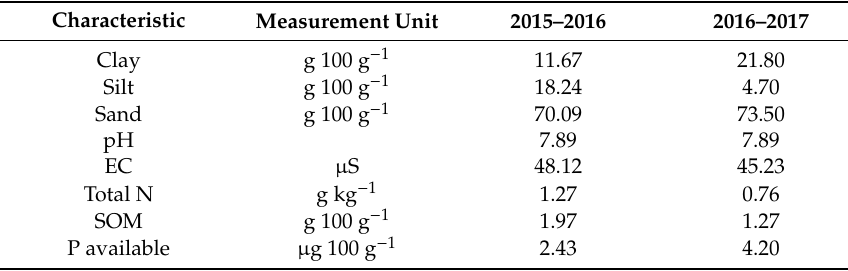
Table 1. Soil characteristics of the fields where the experiments were carried out.